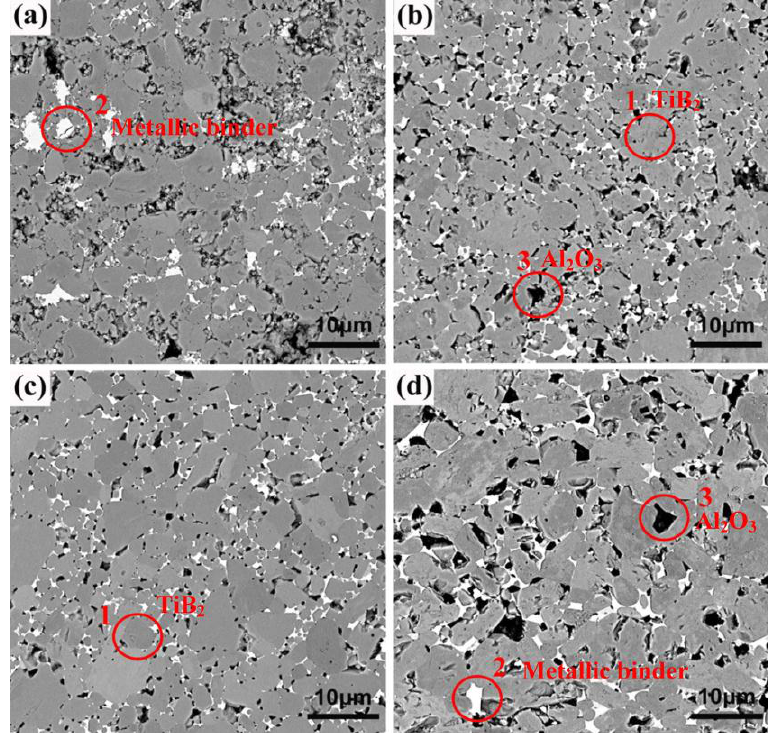
Figure 5. Back-scattered electron microstructures of the TiB 2 –5 wt% (Fe–Ni–Ti–Al) composites sintered at different temperatures: ( a ) 1200 °C; ( b ) 1300 °C; ( c ) 1400 °C; and ( d ) 1500 °C and held for 5 min.